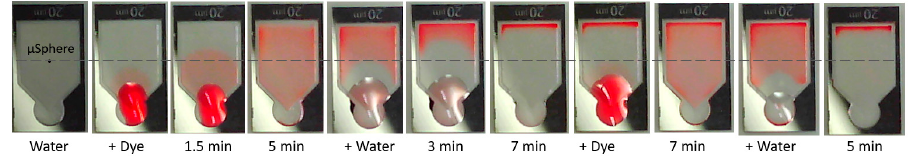
Figure 7. Visual demonstration of the behaviour of the microfluidic system (the 7 mm × 12 mm chip) using Ponceau-4R colour dye.